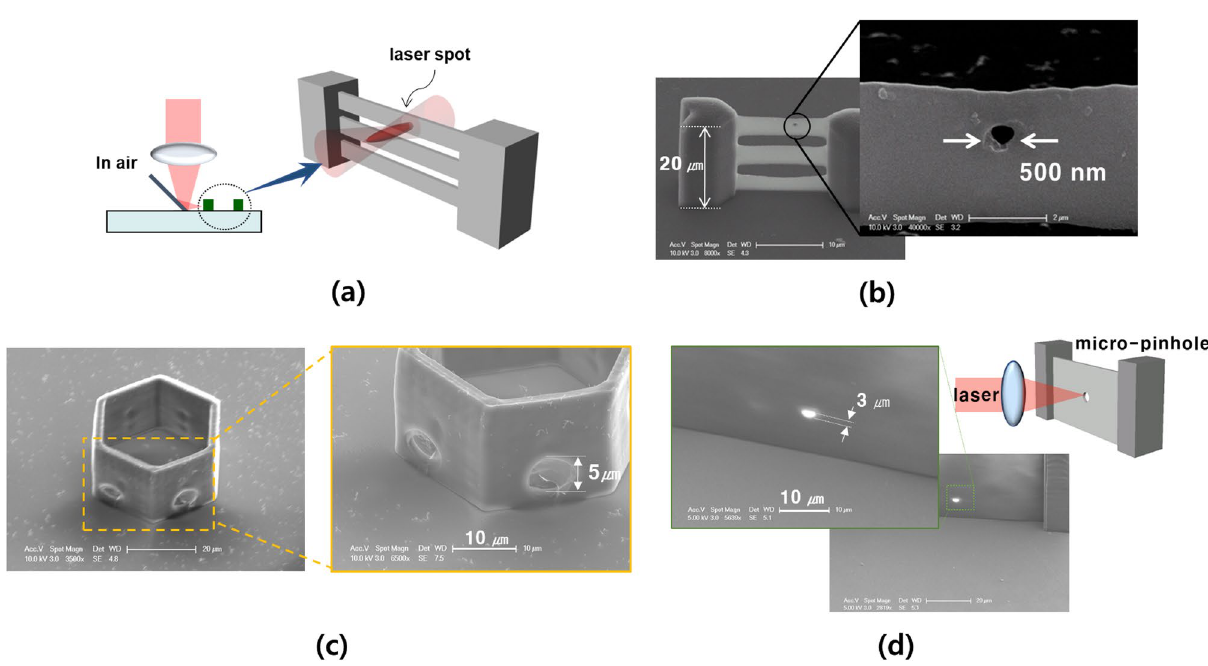
Figure 6. ( a ) Schematic illustration of the multi-direction ablation process. SEM images of the example fabrication by the process. ( b ) Single-point drilling on micro-beam. ( c ) Multi-point drilling on various processing planes. ( d ) Micro-pinhole structures for optical applications such as optical filters or diffraction patterns. The SEM images were measured with a 52° tilted SEM stage. The height was compensated according to 52°